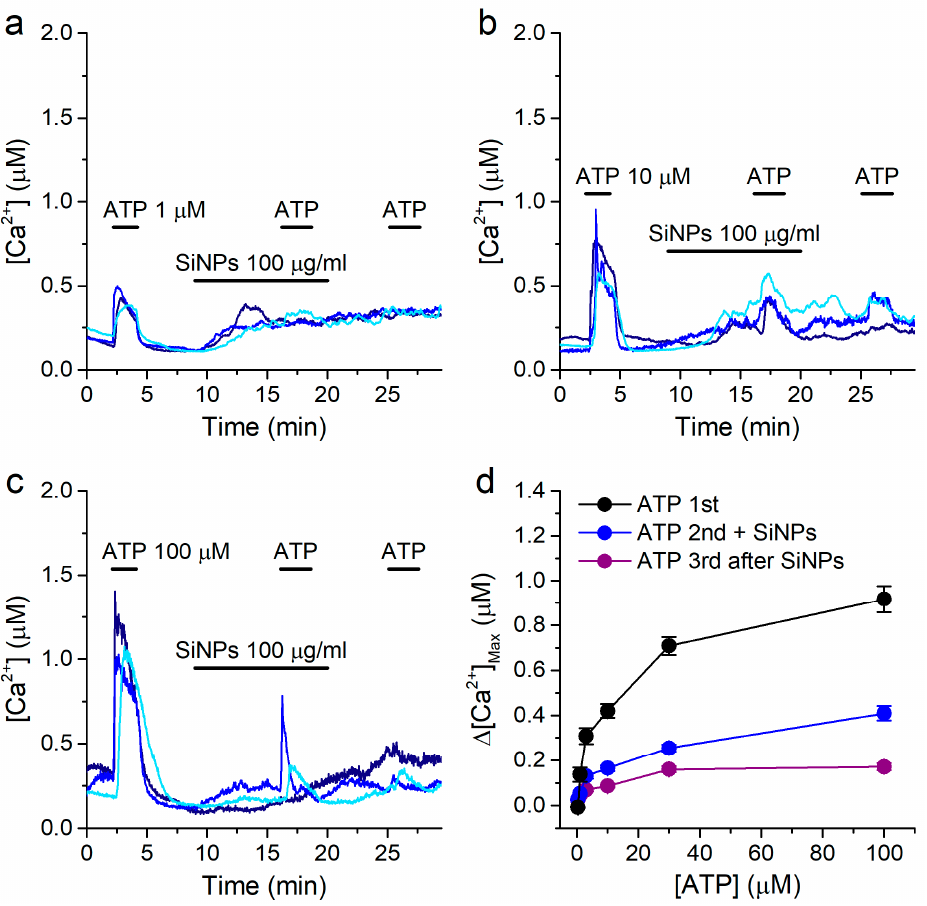
Figure 7. Effects of SiNPs on the concentration dependency of the response to ATP. ( a – c ) Examples of intracellular [Ca 2+ ] traces showing the effects of 100 µ g/mL SiNPs on the responses to extracellular ATP applied at 1 µ M ( a ), 10 µ M ( b ) or 100 µ M ( c ). ( d ) Concentration dependence of the amplitude of the responses to ATP, for the 1st (control), 2nd (in the presence of SiNPs) and 3rd (after washout of SiNPs) applications. The data are represented as mean ± s.e.m. ( n = 213, 68, 130, 109, 169 and 146 for ATP 0.3, 1, 3, 10, 30 and 100 μ M, respectively).